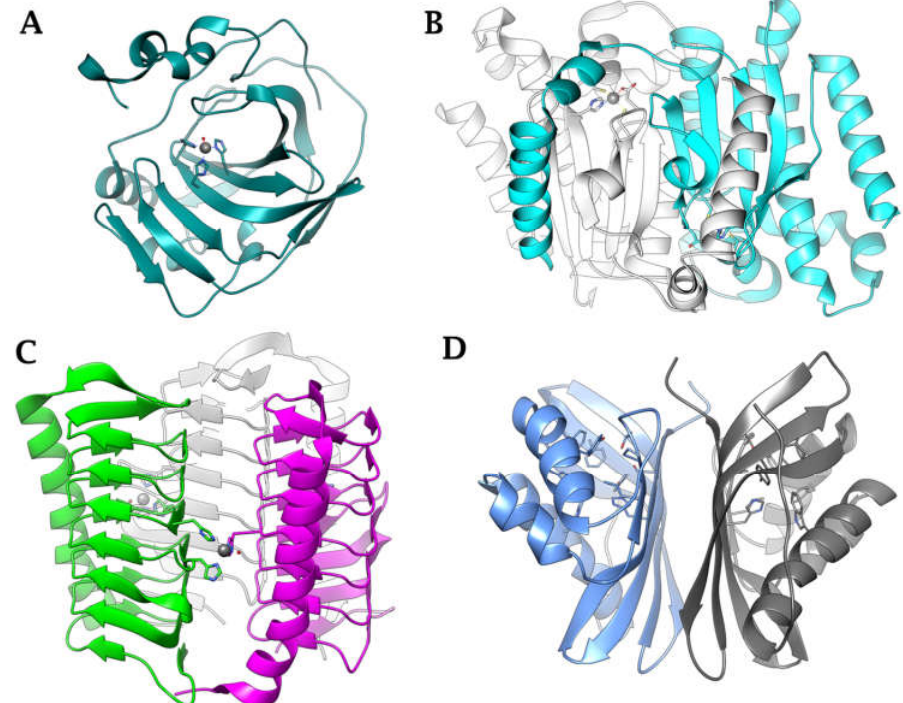
Figure 3. Ribbon view of ( A ) α -CA from Neisseria gonorrhoeae (PDB 1KOQ), ( B ) β -CA from Escherichia coli (PDB 1I6O), ( C ) γ -CA from Burkholderia pseudomallei (PDB 7ZW9), ( D ) ι -CA from B. territorii built by homology using PDB 3H51 as a template.